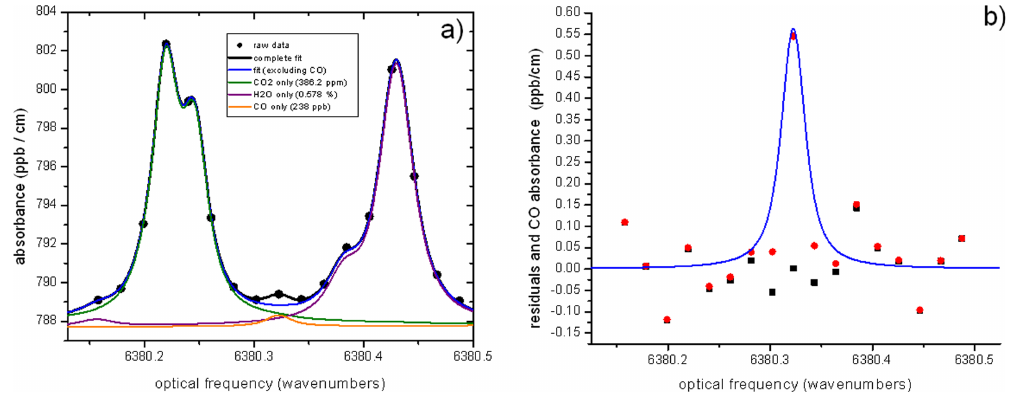
Fig. 1. The spectroscopic data and fits of CO and adjacent absorptions of CO 2 and H 2 O: (a) the spectral fits of absorption data (black solid dots) for CO 2 (four overlapping lines) only, H 2 O (three lines) only, CO only, excluding CO, and all data; (b) the residuals of a multi- component fit to the data in the left panel, with CO included in the fit (black solid squares), and with CO not included (red solid dots), along with the CO spectral fit (blue